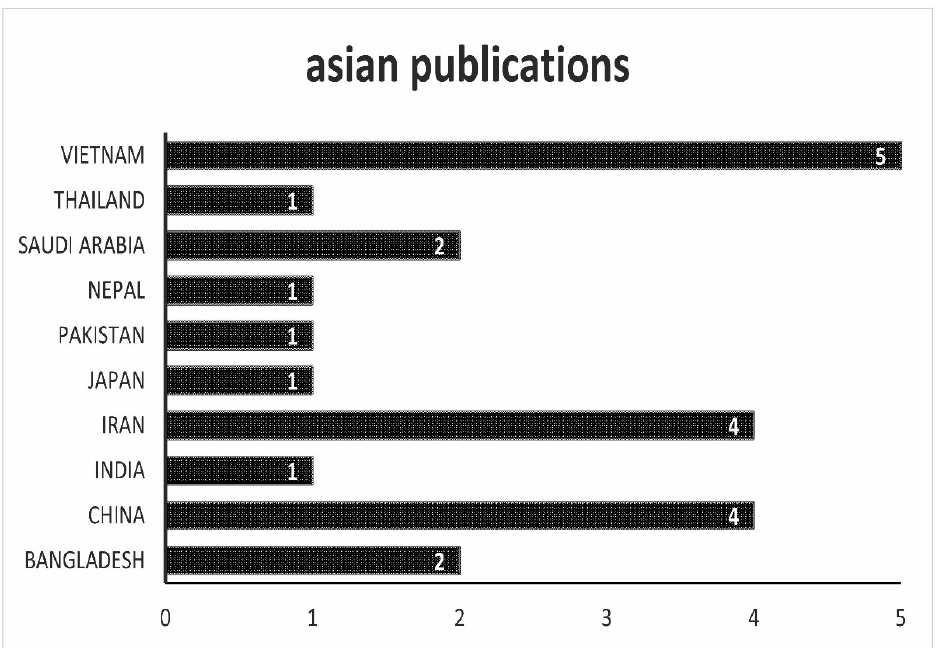
Figure 3. Overview of the origin of the scientific work. In this figure, all works that come from Asia are listed.